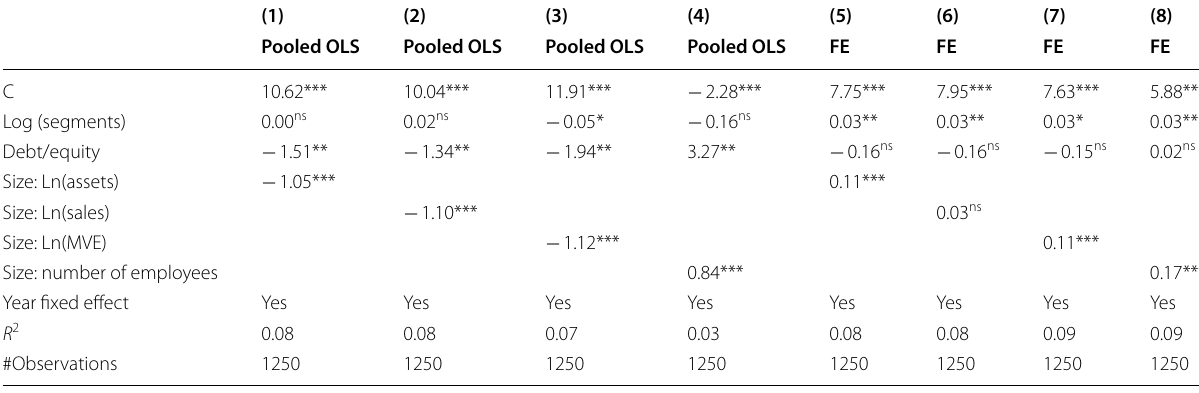
Table 9 Regression analysis of firm size (total asset, total sales, MVE and number of employees) and ROE